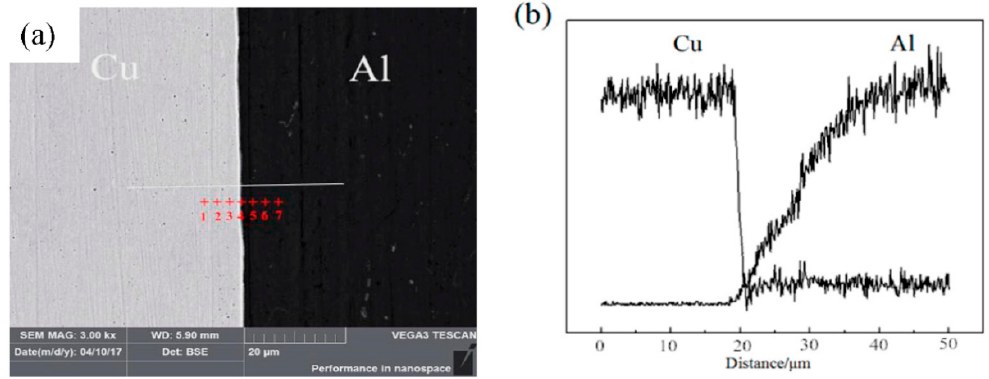
Figure 5. SEM images and line scan spectra of interface in Cu/Al composite panels.